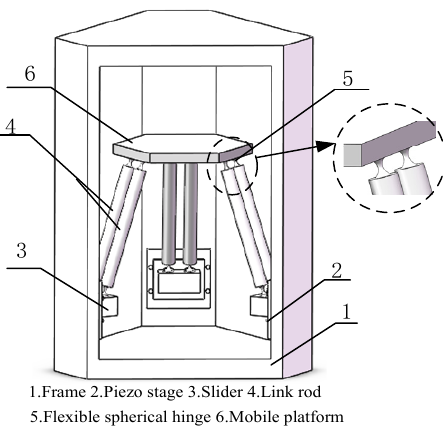
Figure 1. The structure of 3-PSS flexible parallel micro-manipulator.